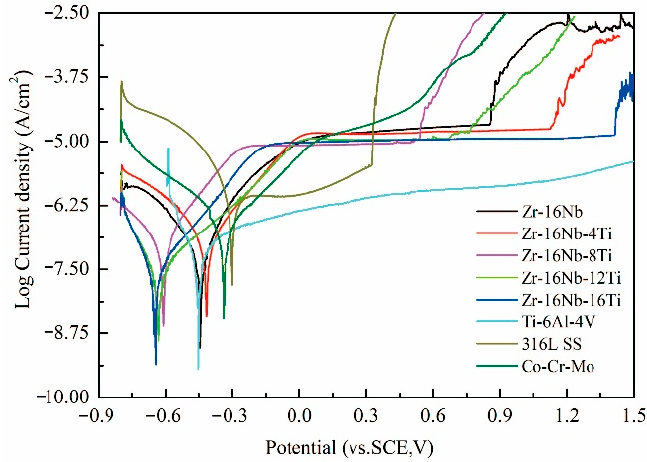
Figure 7. Potentiodynamic polarization curves of the Zr-16Nb-xTi and reference samples. Table 3. Corrosion parameters of the Zr-16Nb-xTi and reference alloys.